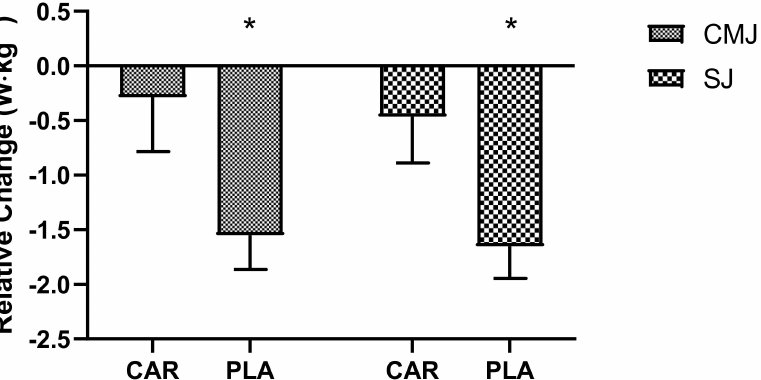
Figure 6. Maximum relative power output delta. Mean values and error bars for the standard error of